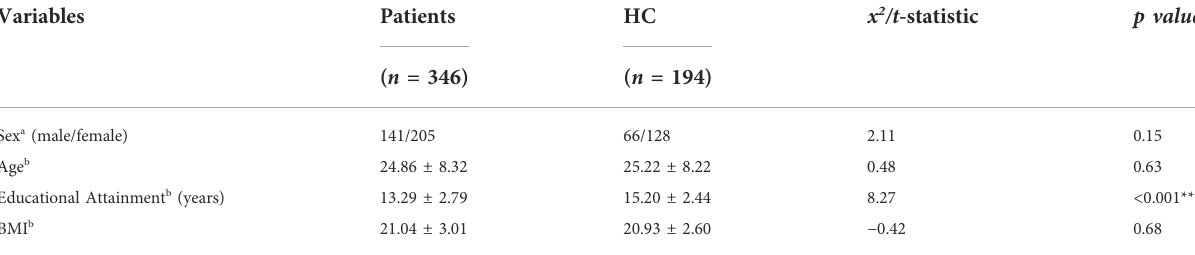
TABLE 1 Comparison of demographic characteristics between the psychiatric patient and healthy control groups.